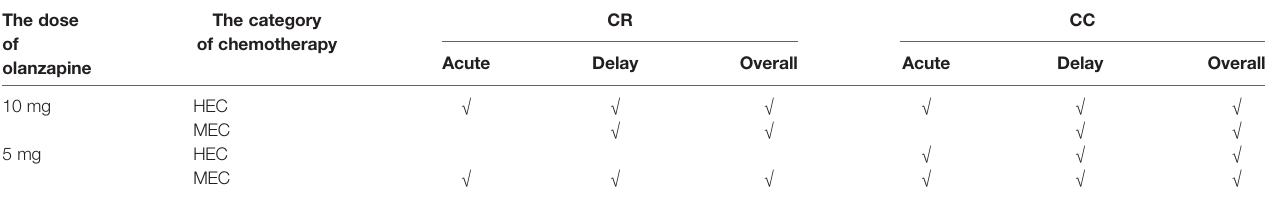
TABLE 5 | Clinical advantages of olanzapine for the prophylaxis of CINV. The dose of